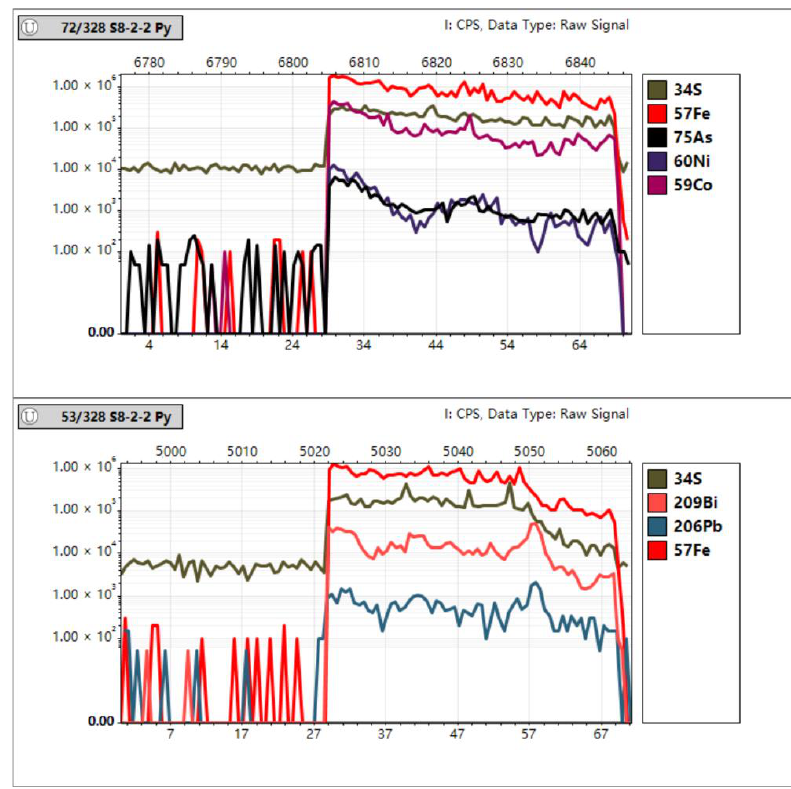
Figure 11. Time-resolved depth profiles of Co, Ni, As, Bi, and Pb in Sample S8-2.